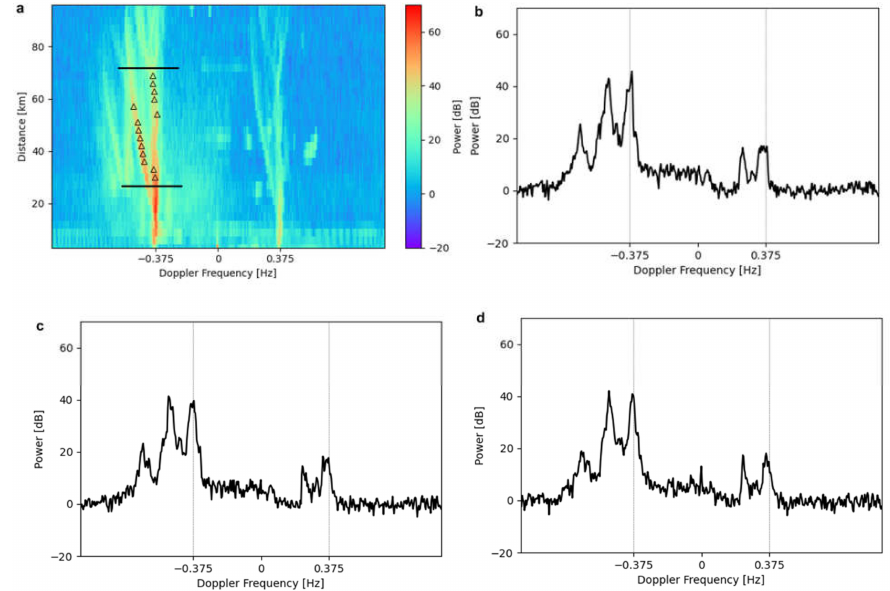
Figure 4. Example of the double-peak spectrum. ( a ) The range-Doppler spectrum of beam 12 at 14:00 JST on 19 January 2019 at Miyazaki Station. There is another peak with almost the same power as the first-order echo peak from around 30 km to around 70 km. Triangles indicate first-order echo peaks from 30 km to 69 km. The Doppler spectrum in ( a ) at ( b ) 54 km, ( c ) 57 km, and ( d ) 60